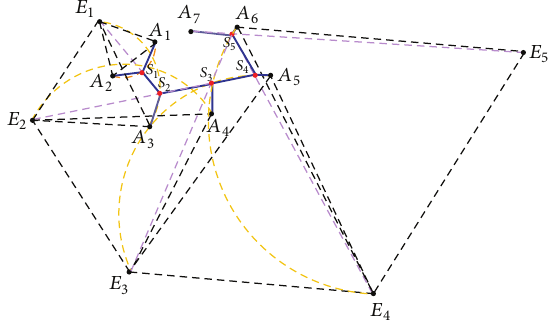
Figure 7: SMT of seven points in Melzak.